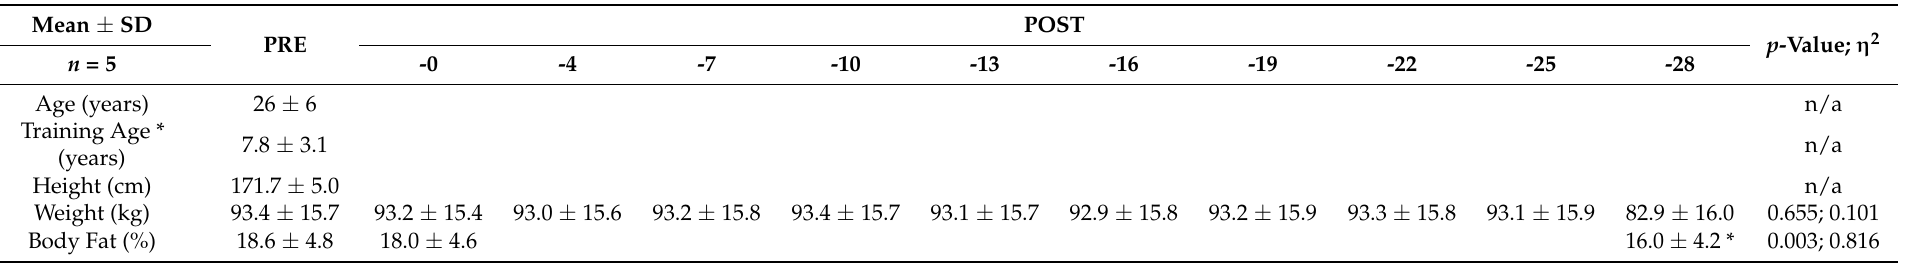
Table 1. Participant demographics, anthropometrics, and body fat (BF%). All data are presented as the means ± SD and performed at a significance level of p < 0.05.